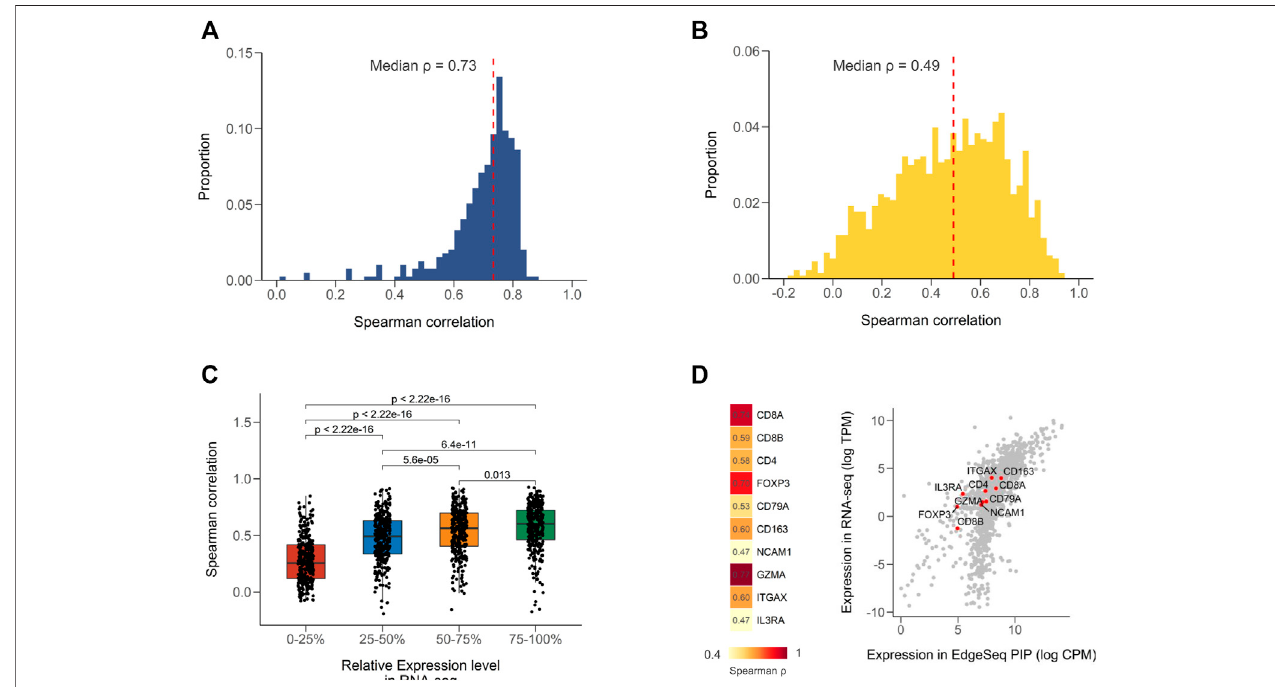
FIGURE 1 | Concordance of EdgeSeq PIP with RNA-seq at gene level. (A) Distribution of sample-wise Spearman correlation coef fi cients between EdgeSeq PIP and RNA-seq. Dashed line represents the median value. (B) Distribution of gene-wise Spearman correlation coef fi cients between EdgeSeq PIP and RNA-seq. Dashed line represents the median value. (C) Boxplot showing the difference of Spearman correlation coef fi cients across genes strati fi ed by their relative expression level (quartile) in RNA-seq. (D) Heatmap showing the Spearman correlation of key immune cell markers (left) and scatter plot showing their expression levels (right) in EdgeSeq PIP ( x -axis) and RNA-seq ( y